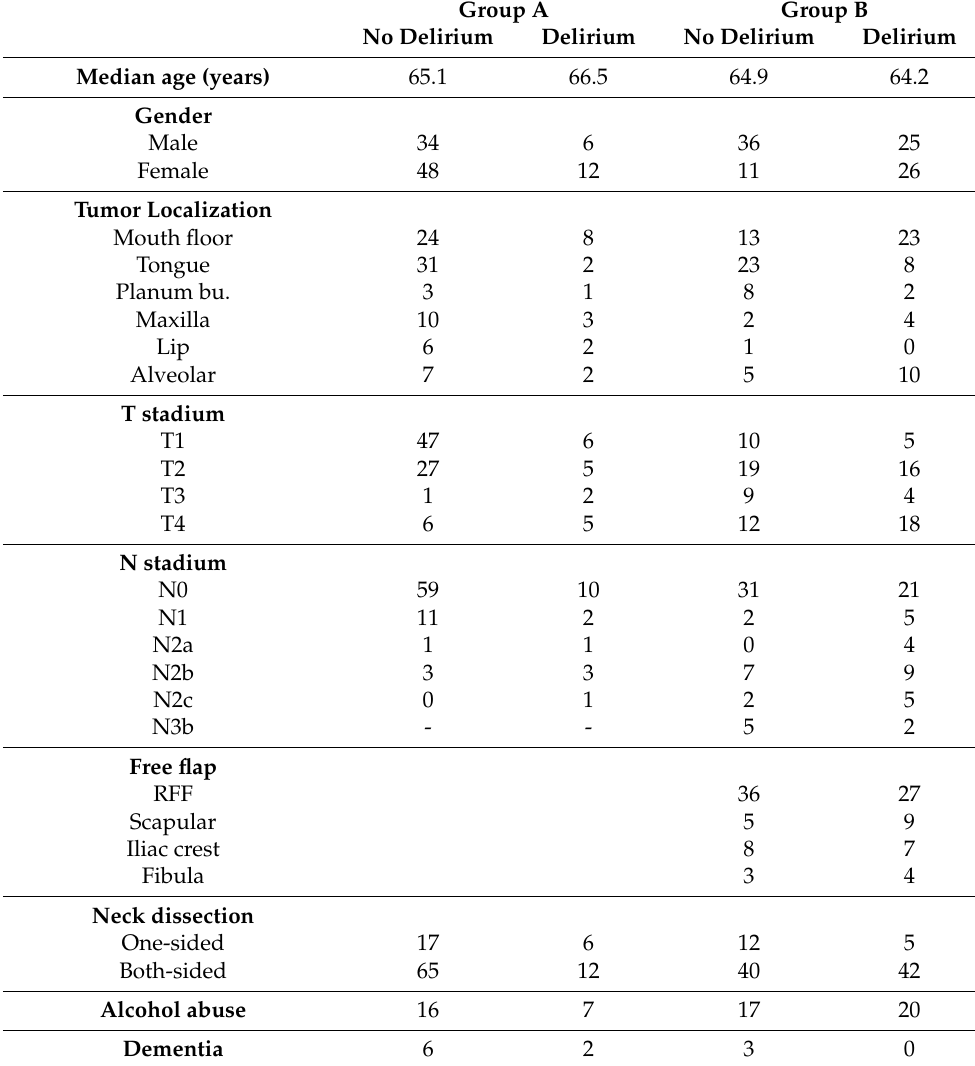
Table 1. Overview of demographic and oncological data for groups A and